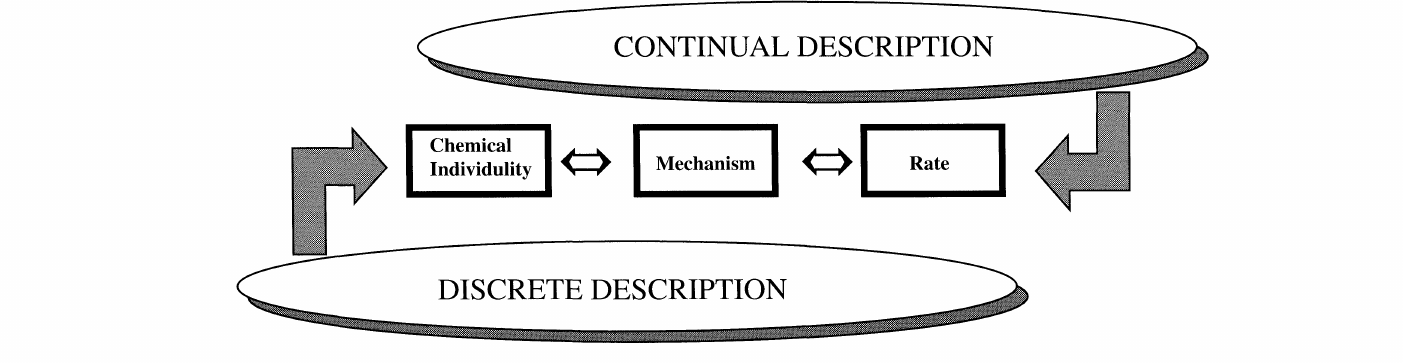
In describing the dynamics of solid state chemical reactions the problem is approached in discrete and continual terms from the opposite